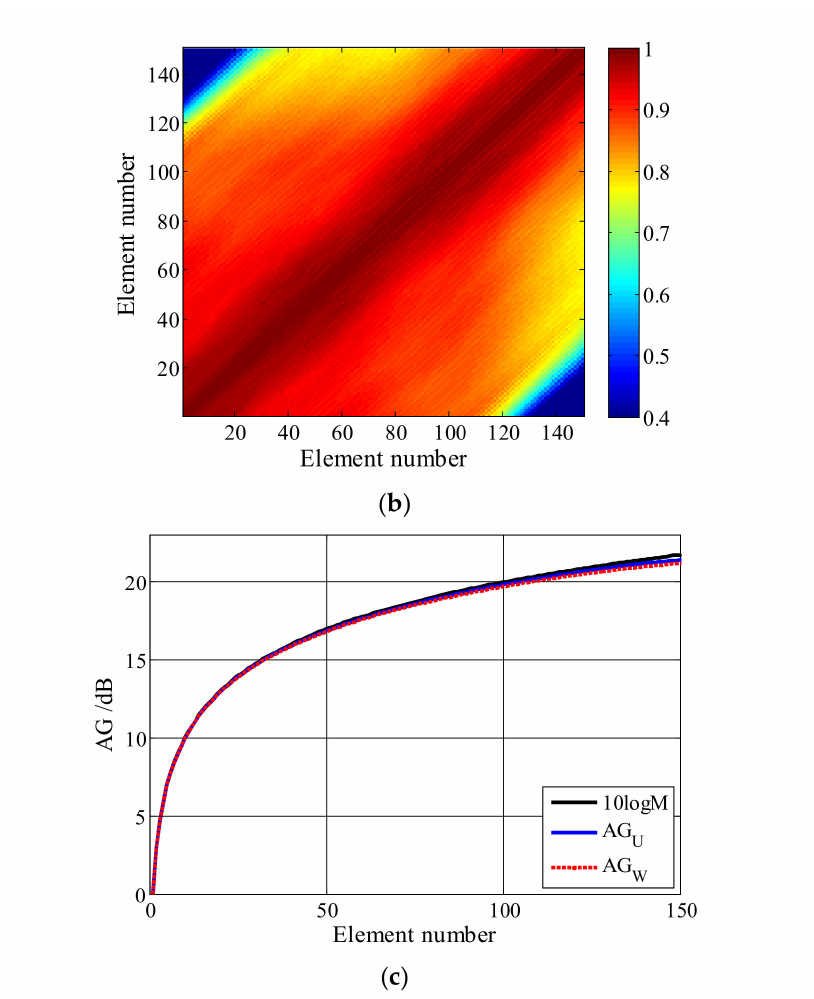
Figure 3. Fluctuant acoustic channels and AGs for the receiving depth of 120 m and distance of 49 km in the shallow water: ( a ) ATL s on the elements; ( b ) Correlation coefficients; ( c ) AG U (blue solid line), AG W (red dash line) and the ideal value of AG (black solid line) varying with the element